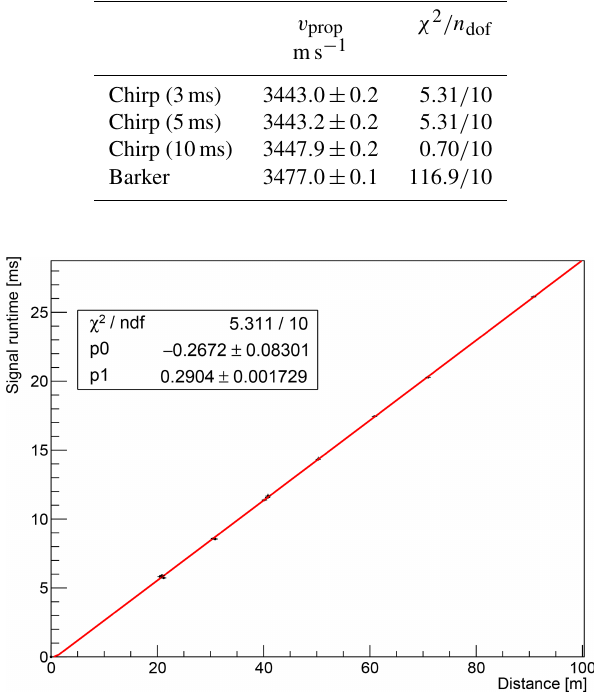
Figure 12. Measured propagation delay for 5ms chirp signals.